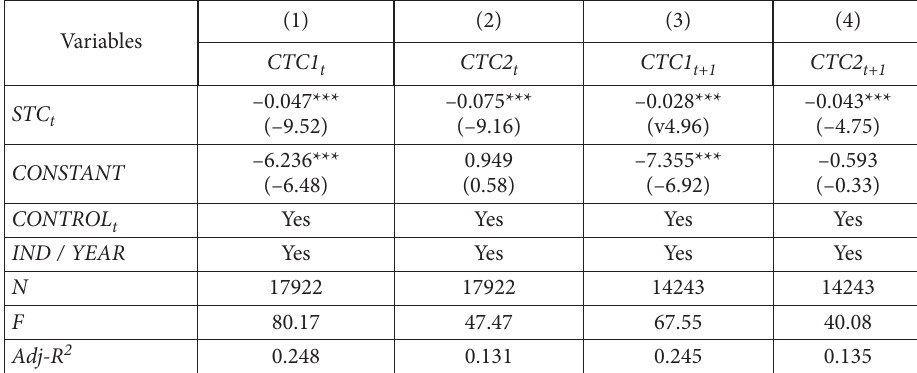
Table 3. Testing the substituting financing effect of suppliers’ trade credit on customers’ trade